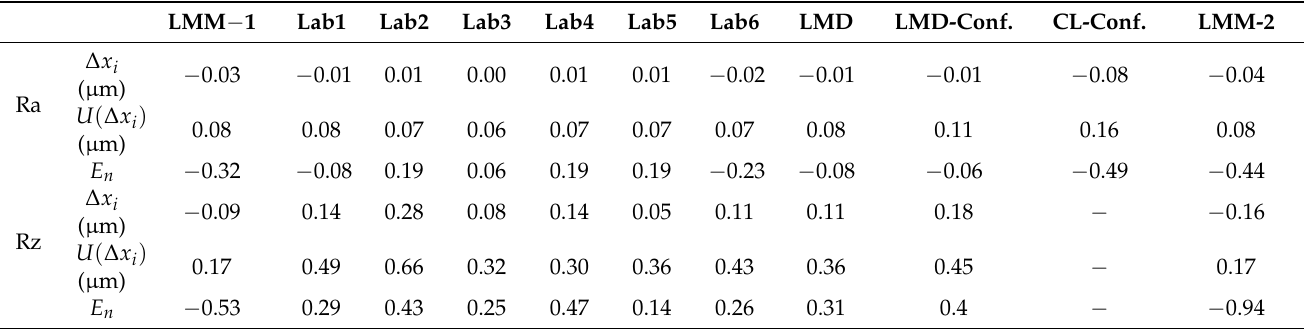
Table 2. Statistical